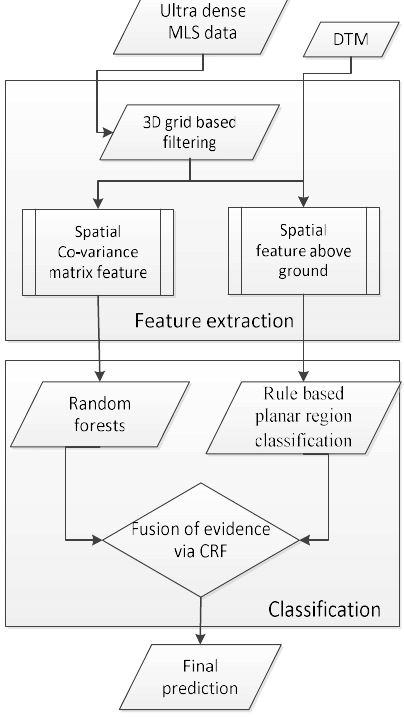
Figure 1. Workflow for the proposed labelling